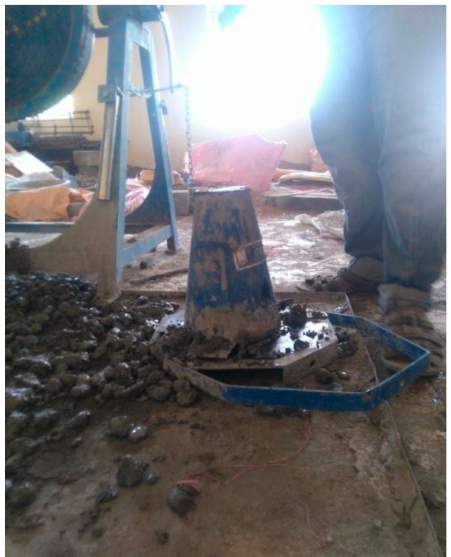
Figure 2. Slump cone test on concrete mixes.